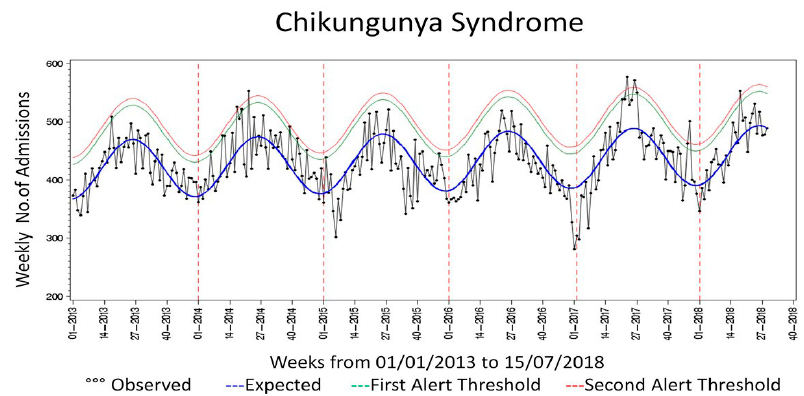
Figure 1. Number of Emergency Department (ED) admissions expected value and alert threshold for Chikungunya Virus (CHIKV) Syndrome. Blue Line, Expected number of ED admissions; Green Line, upper 95% confidence interval for the expected number of ED admissions (first alert threshold); Red Line, upper 99% confidence interval for the expected number of ED admissions (second alert threshold).